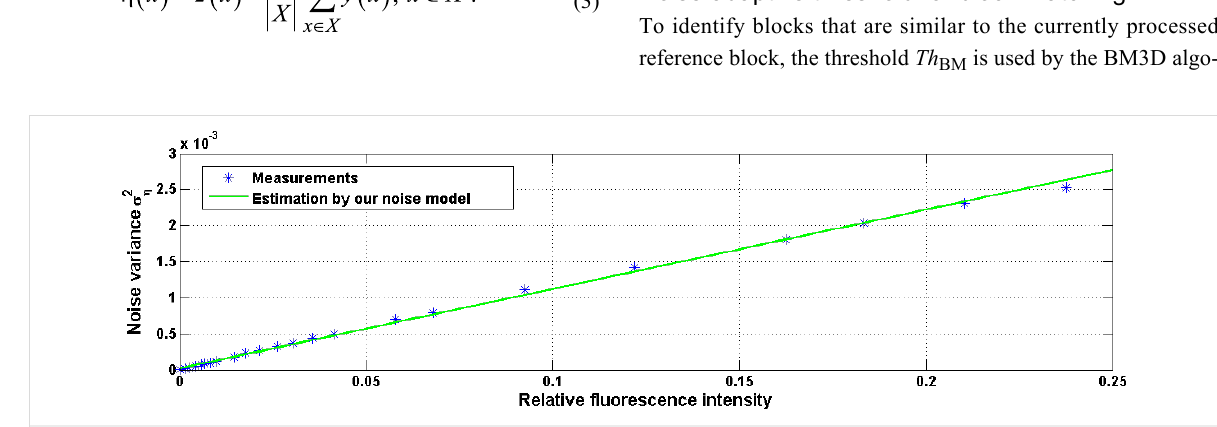
Figure 3: Verification of the noise model: comparison of noise variance measurements ( σ η 2 ) with estimations proposed by the noise model. The data show that the noise model closely fits the 2PM measurements.